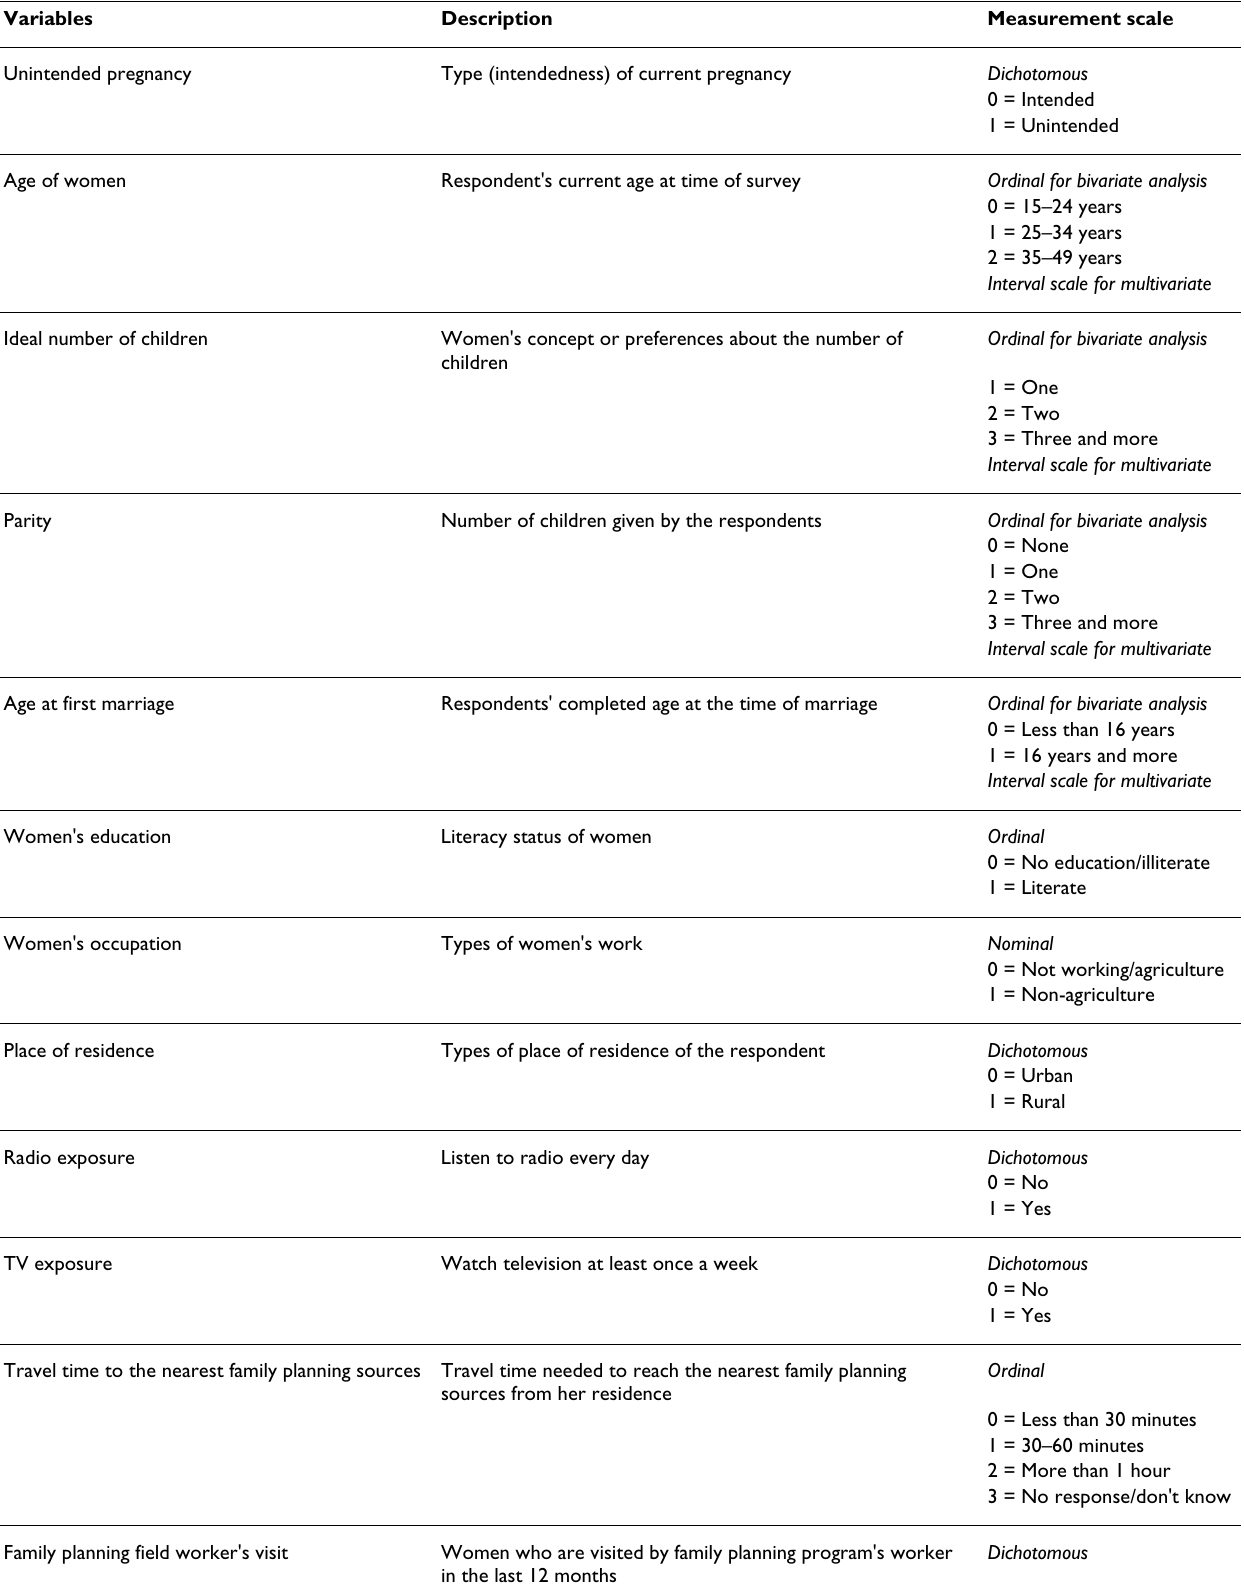
Table 1: Operational definitions of variables and their measurements